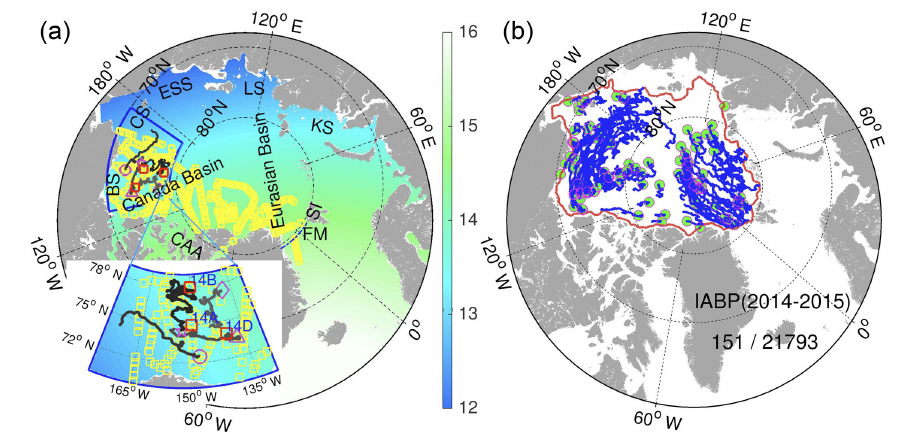
Figure 1. (a) Horizontal resolution (km) of the model grid in the Arctic ( > 60 ◦ N). The small yellow squares are the locations of IceBridge campaigns during the experimental period. The marginal seas are as follows: Beaufort Sea (BS; also shown with the blue line), Chukchi Sea (CS), East Siberian Sea (ESS), Laptev Sea (LS) and Kara Sea (KS); and the other regions are as follows: Canadian Arctic Archipelago (CAA), Svalbard Island (SI) and Fram Strait (FM). The four purple markers (star, circle, triangle and diamond) are the deployment location of IMB buoys (2013F, 2014B, 2014C, and 2014F respectively) with the following trajectory shown as black solid curves. The three red squares are the fixed locations of the BGEP moorings (14A, 14B and 14D, respectively). (b) Trajectories of International Arctic Buoy Program buoys drift during the experimental period. The solid red line delimits the coastal areas excluded in the